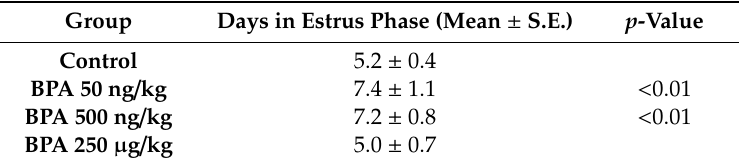
Table 2. In utero exposure to low dose BPA interrupts the estrous